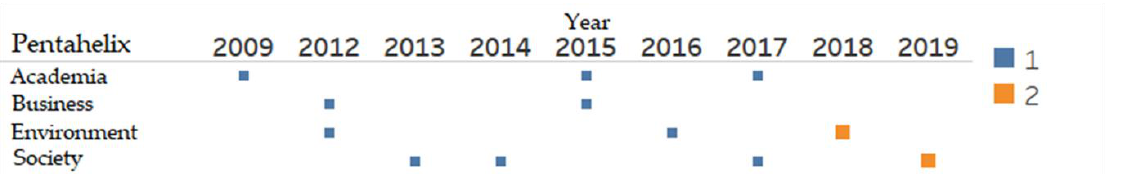
Figure 5. Grouping of SAK’s experiences by pentahelix sector and year.